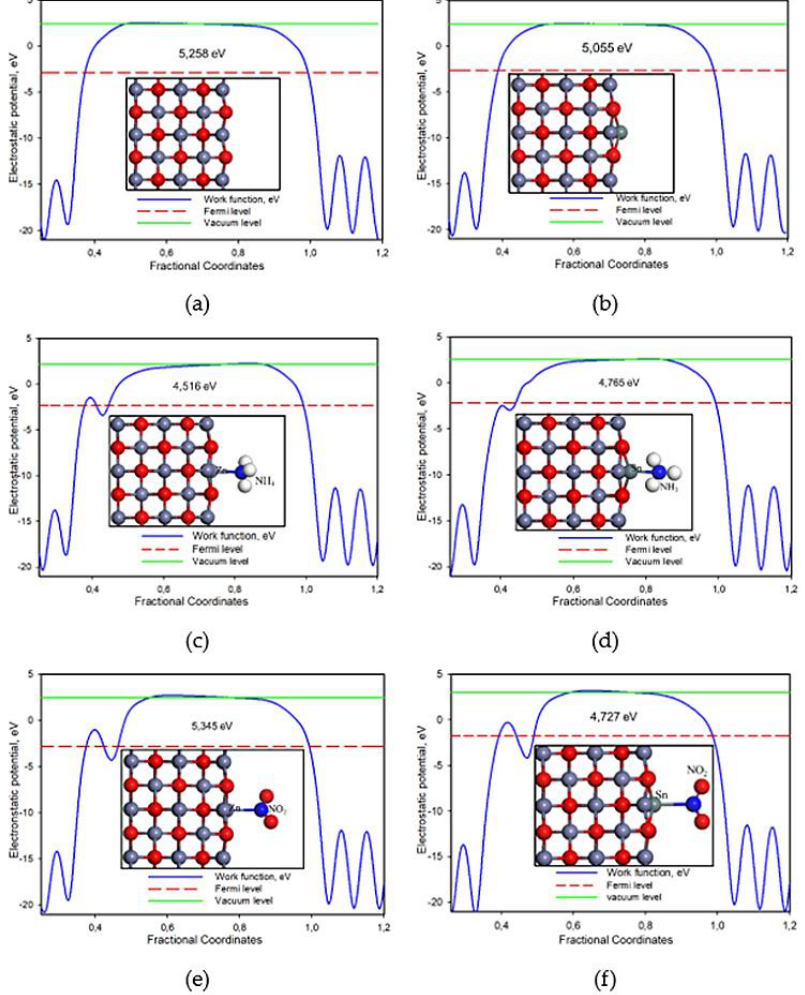
Figure 6. Work function plots for pure and adsorbed surfaces ( a ) pure ZnO (101), ( b ) Sn − doped ZnO, ( c ) NH 3 /ZnO (101), ( d ) NO 2 /ZnO (101), ( e ) NH 3 /Sn − doped ZnO (101), and ( f ) NO 2 /Sn-doped ZnO (101).